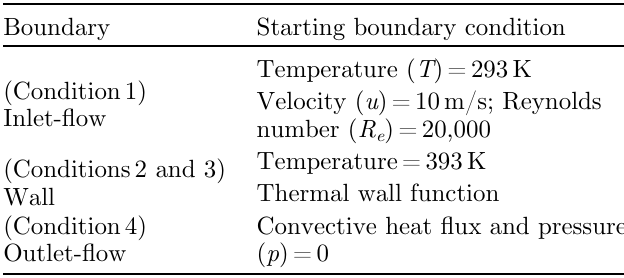
Table 3. Starting boundary conditions applied to heat transfer and fl uid fl ow simulation.